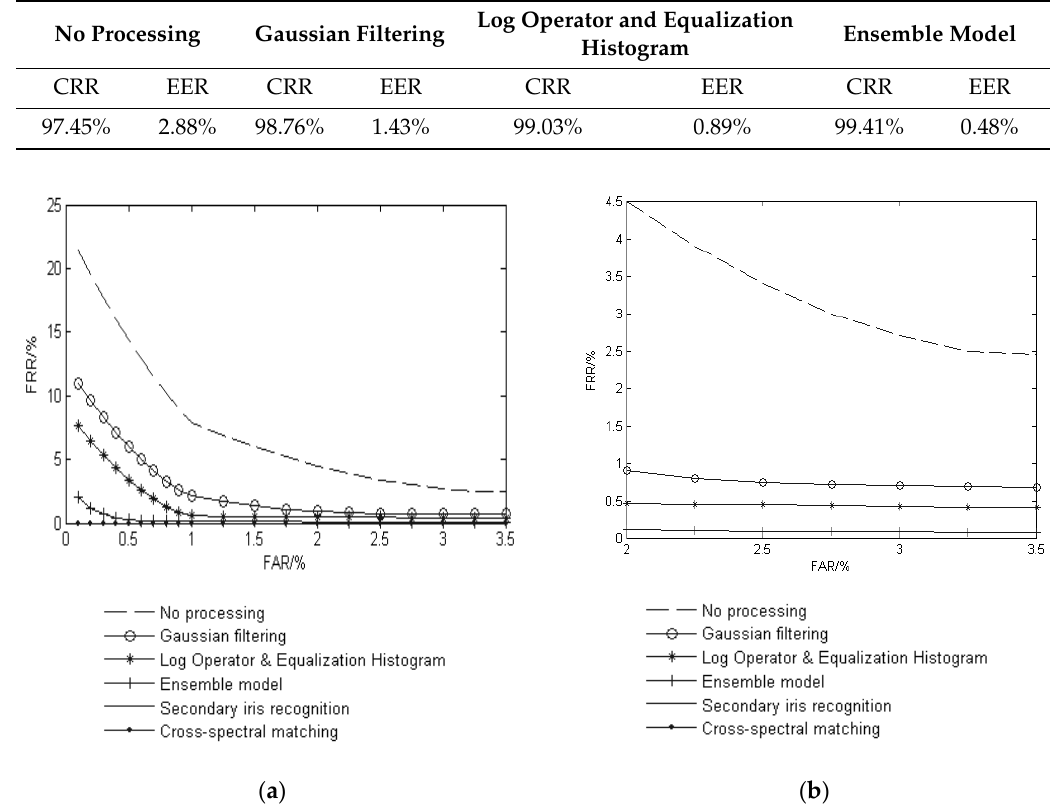
Figure 12. The ROC curve of JLU-5.0: ( a ) Global map; and ( b ) Partial magnification.